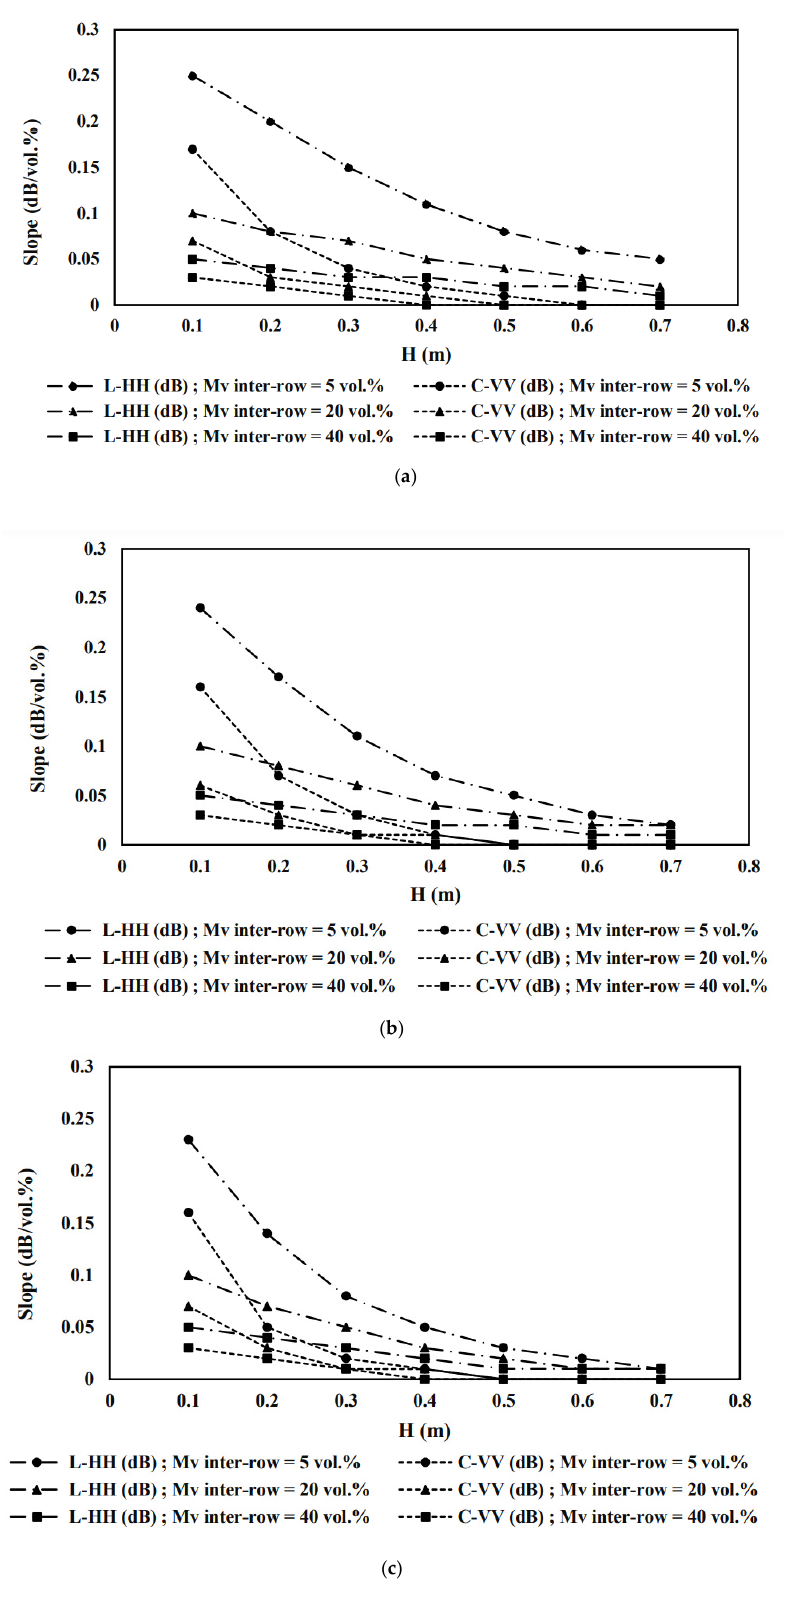
Figure 11. Scatterplots of the modified WCM sensitivities to soil moisture as a function of the pepper vegetation height (H) using L-HH and C-VV data in three different contexts of inter-rows soil moisture (5 vol.%, 20 vol.% and 40 vol.%) with constant values of cover fraction ( a ) Fc = 0.1, ( b ) Fc = 0.3 and ( c ) Fc = 0.6. Figure 11a represents simulation results when cover fraction is equal to 0.1 in dif ‐ ferent soil moisture contexts. Globally, the model sensitivities decrease as function of pepper height increase. Using L ‐ HH data, the model sensitivities vary from 0.25 to 0.10 dB/vol.%.